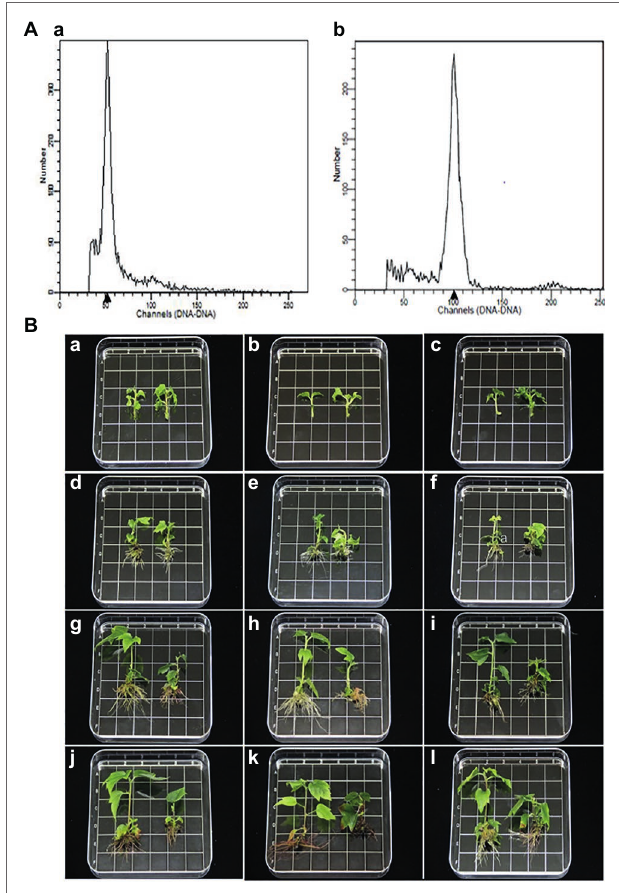
FIGURE 1 | (A) Histograms of flow cytometry findings for Liquidambar styraciflua × Liquidambar formosana : a diploid plant (control); b tetraploid plant. (B) Morphological comparison of diploid and tetraploid hybrid sweetgum plants at various developmental stages of in vitro growth. a,d,g,j Z1; b,e,h,k Z2; c,f,i,l Z3. a–c : 0 d; d–f : 25 d; g–i : 50 d; j–l 70 d. a–l tetraploid on the right and diploid on the left in each picture. Area of each square: 1 × 1 = 1 cm 2